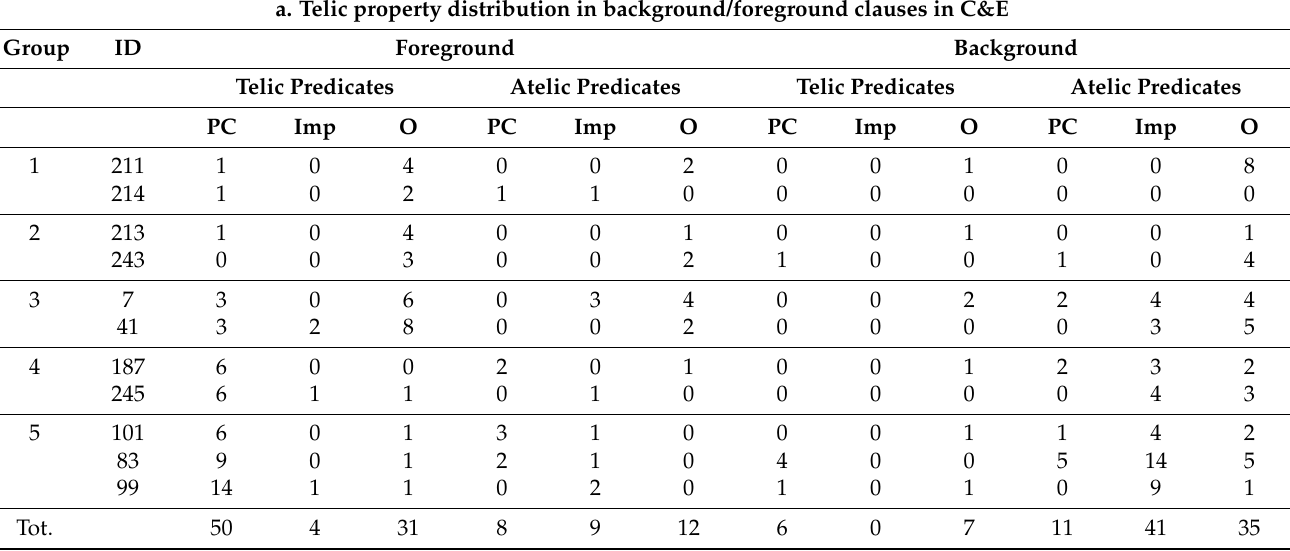
Table 6. Telic property distribution in background/foreground